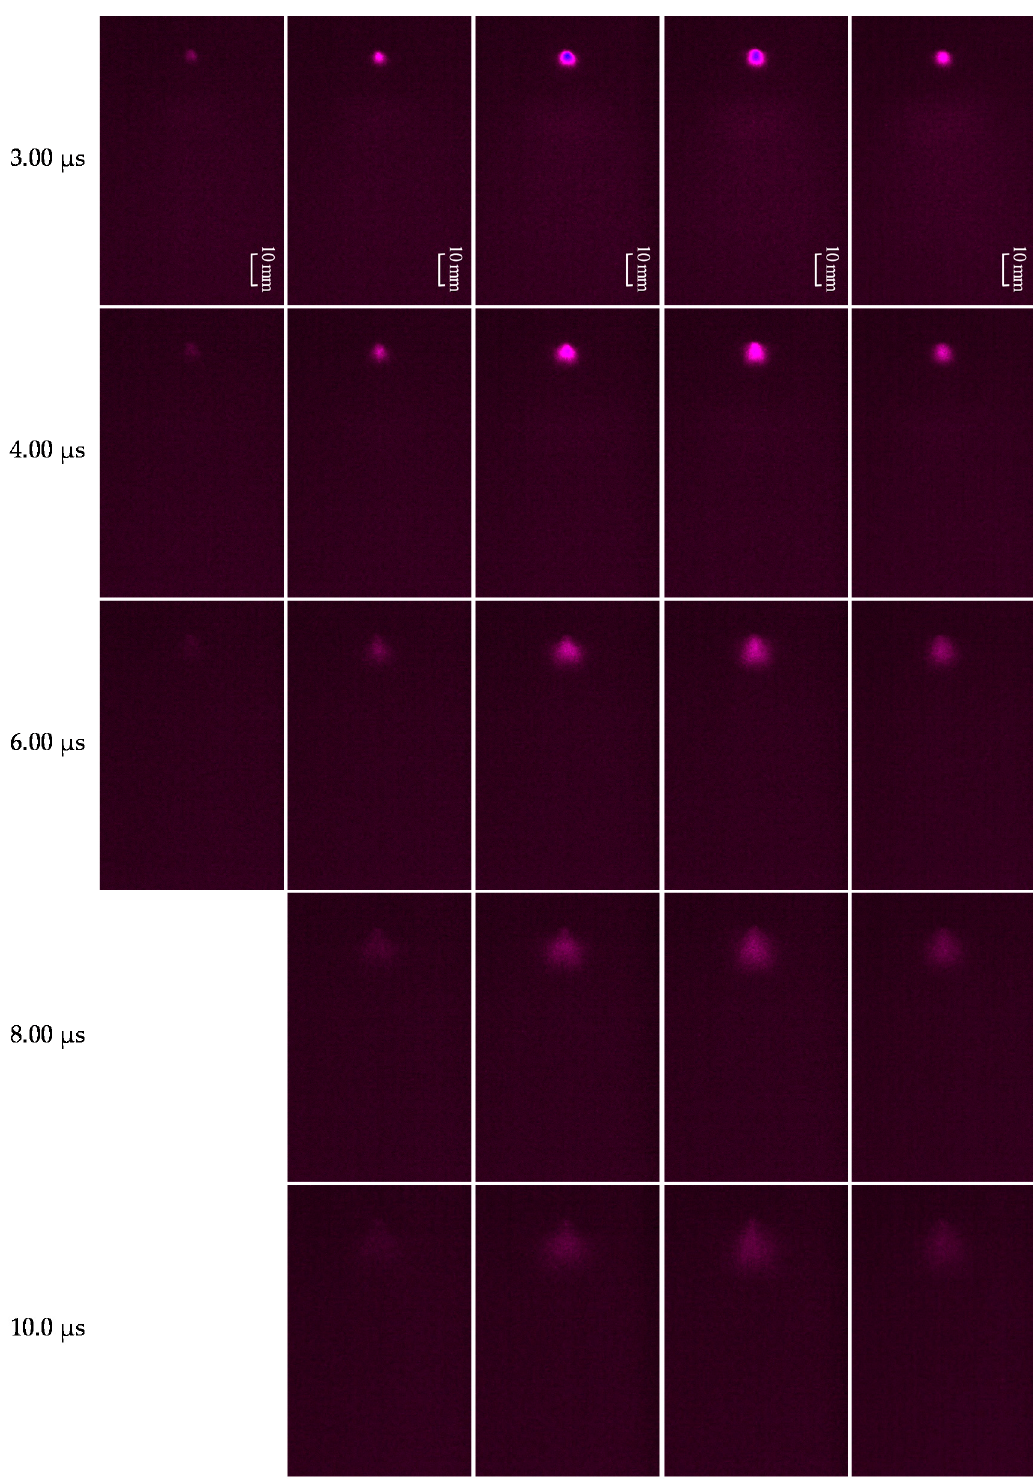
Figure 8. The evolution process of laser ablation plume at different proportions of Al (ambient pressure 0.005 Pa and laser energy 542.3 mJ).